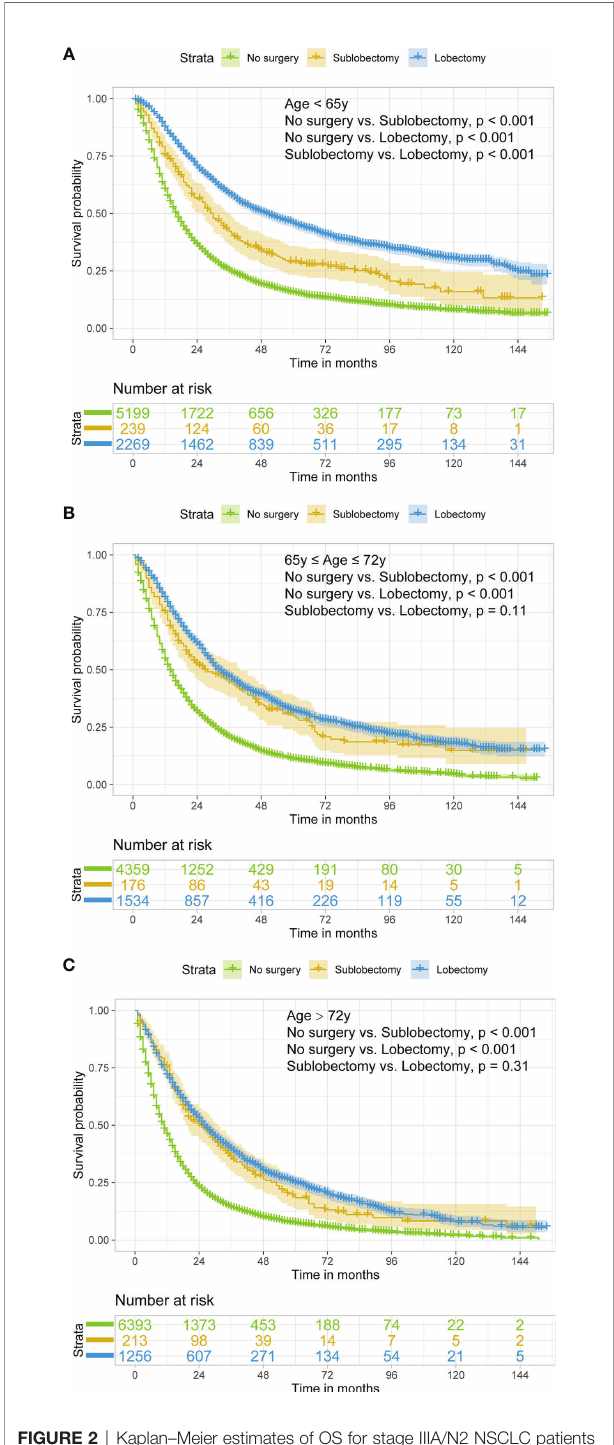
FIGURE 2 | Kaplan – Meier estimates of OS for stage IIIA/N2 NSCLC patients aged <65 years old (A) , 65 – 72 years old (B) , and >72 years old (C) strati fi ed by surgery strategy. OS, overall survival; NSCLC, non-small cell lung